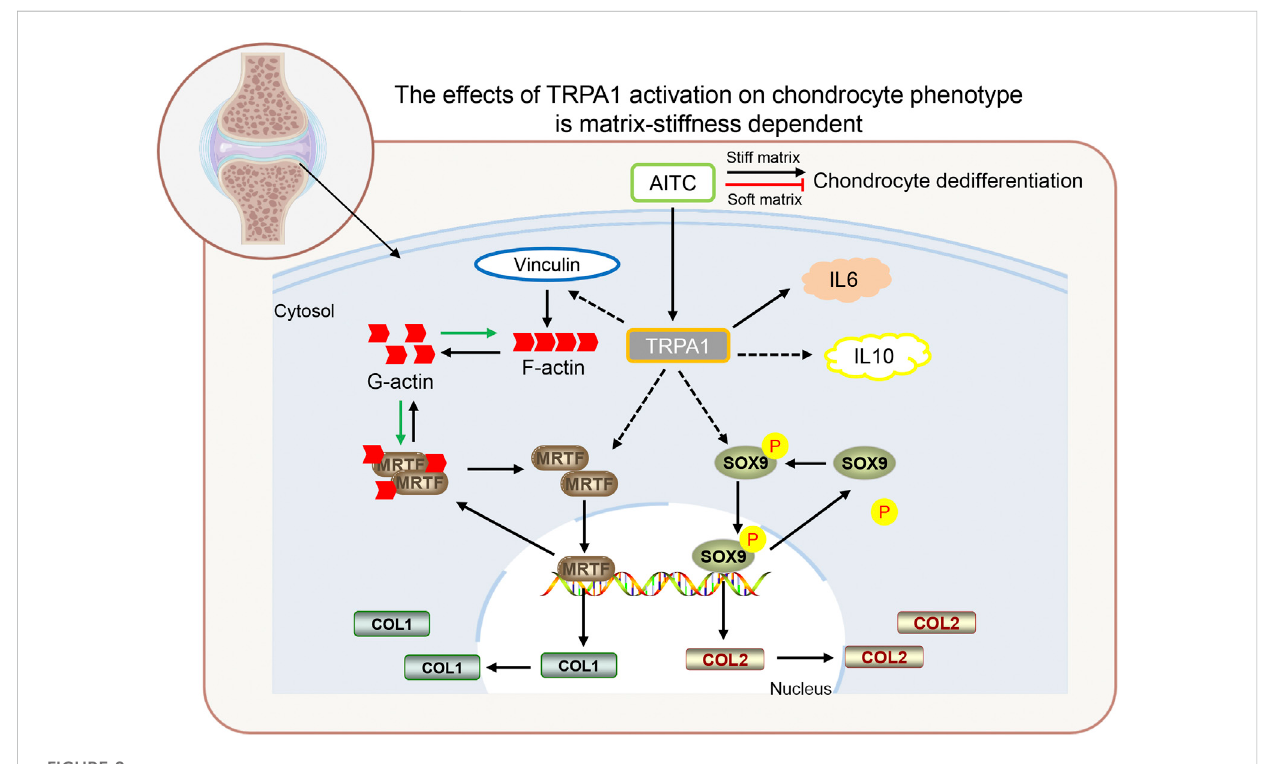
Proposed model depicting the TRPA1 activation in regulating CH dedifferentiation during OA. In general, TRPA1 activation promotes CH dedifferentiation on a stiff matrix but prevents CH dedifferentiation on a soft matrix. The AITC induces TRPA1 activation, which triggers vinculin upregulation and follows an increased F-actin expression. TRPA1 activation also induces the MRTF-A and pSOX9 upregulation, which transfers into the nucleusandcodescollagen Ⅰ and Ⅱ expression.Inaddition,TRPA1activationcanincreasebothIL-6andIL-10expression.(Therelationsindicatedby the solid lines are those veri fi ed in previous studies and those indicated by the dashed lines are newly identi fi ed in this